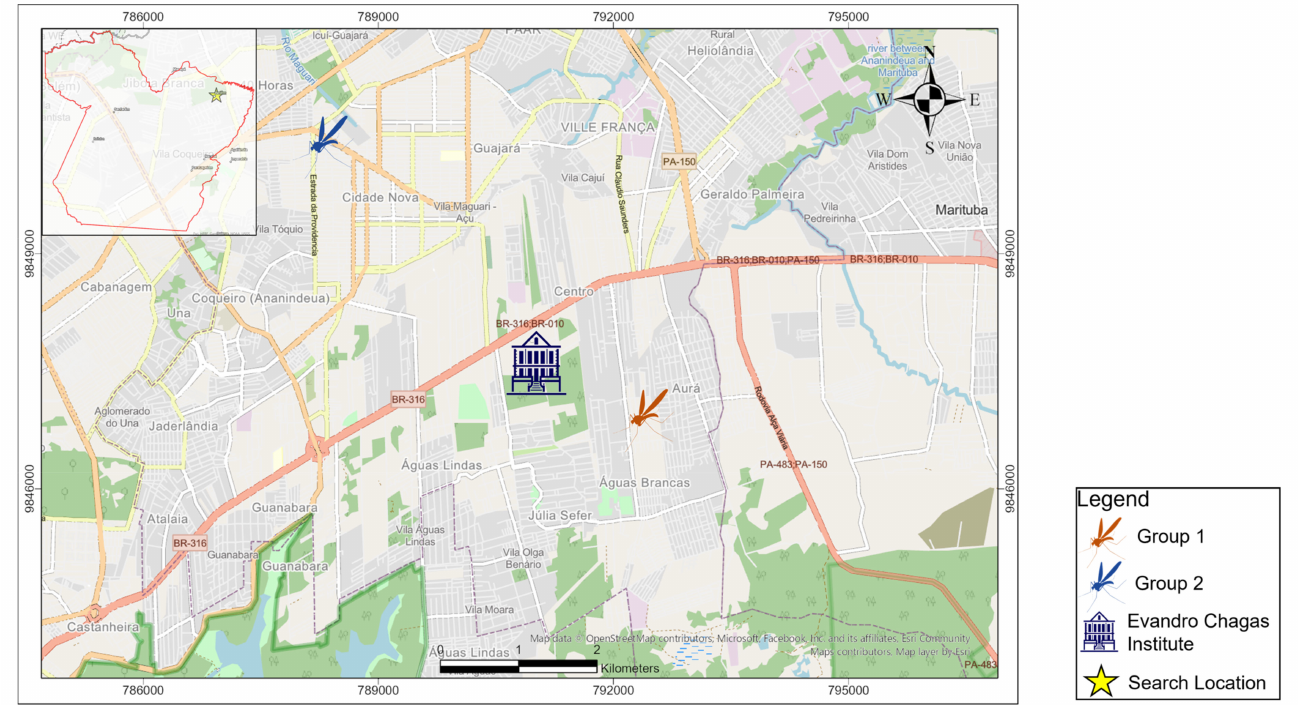
Figure 1. Map of the areas of origin of the generations of mosquitoes used in the study. Group 1 from the neighborhood of Á guas Lindas and Group 2 from the neighborhood of